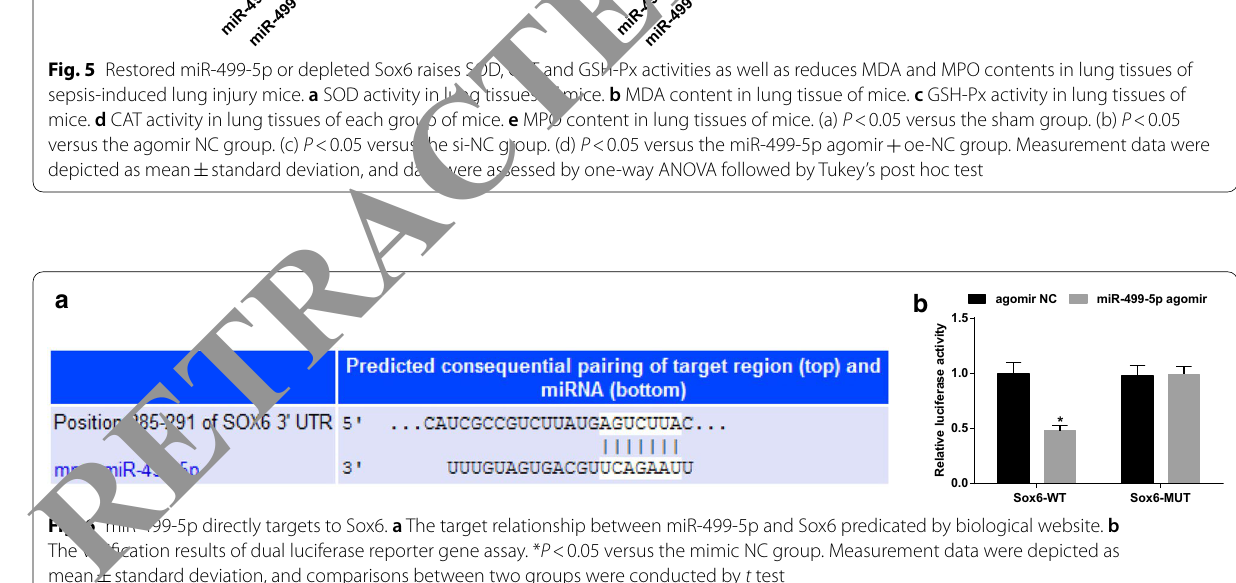
Fig. 6 miR-499-5p directly targets to Sox6. a The target relationship between miR-499-5p and Sox6 predicated by biological website. b The verification results of dual luciferase reporter gene assay. * P < 0.05 versus the mimic NC group. Measurement data were depicted as mean standard deviation, and comparisons between two groups were conducted by t ±